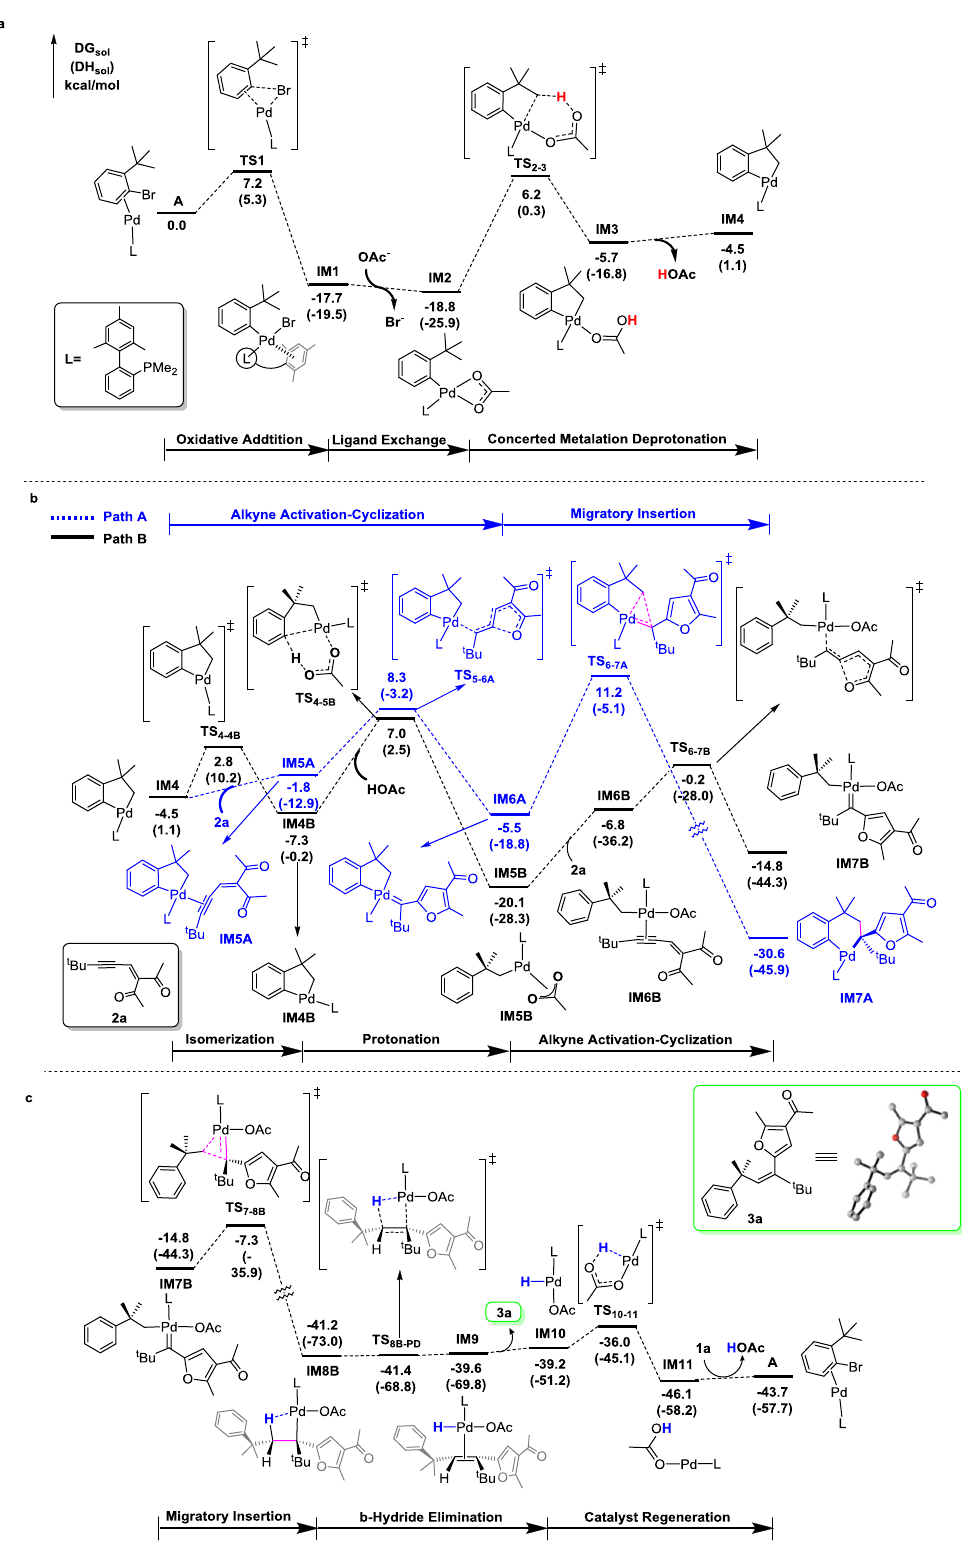
Fig. 8 Energy pro fi les calculated on the basis of the mechanistic cycles shown in Fig. 7. a Oxidative addition followed by CMD leading to the key palladacycle intermediate IM4 , b two different paths starting from IM4 , and c catalyst regeneration for the favorable path (Cycle B). The solvation- corrected relative free energies and electronic energies (in parentheses) are given in